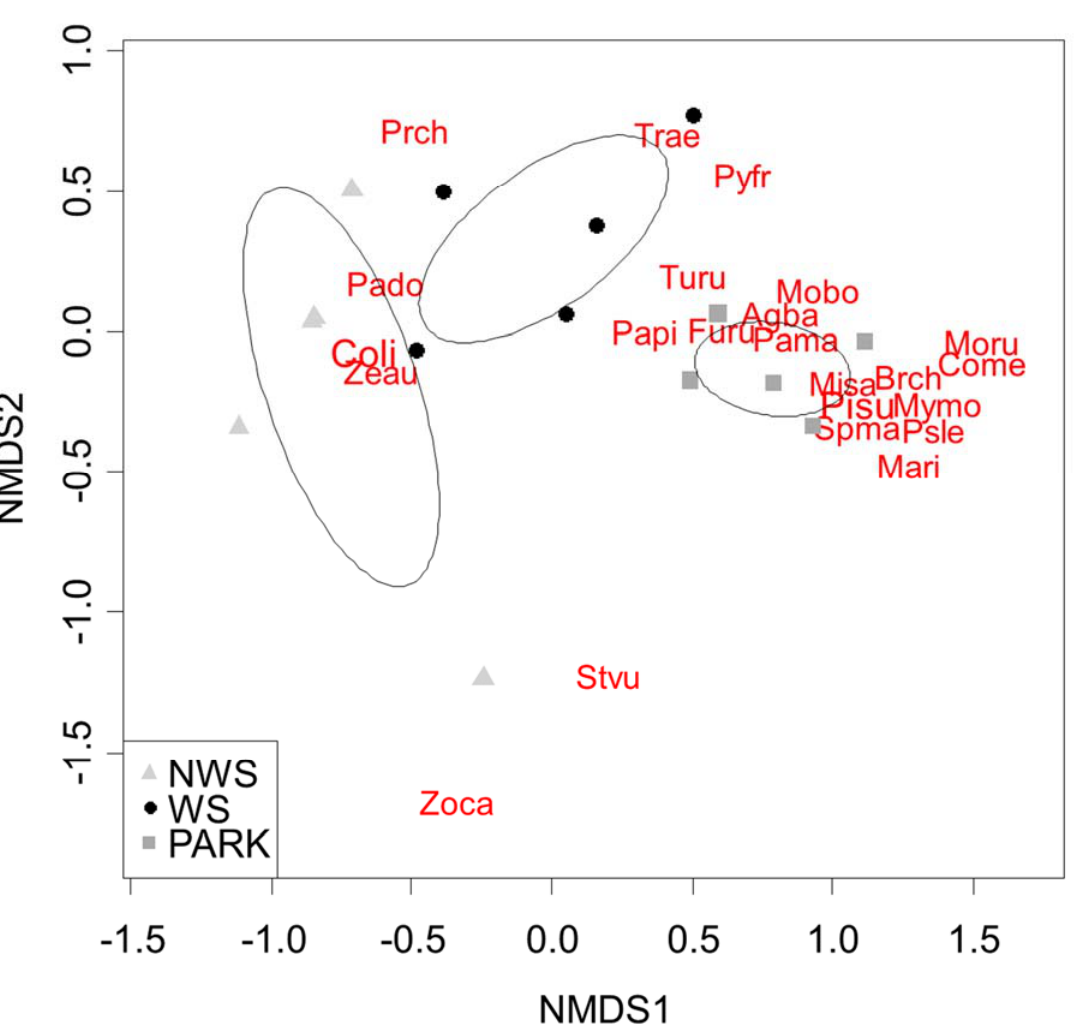
Figure 3. Non-metric multidimensional scaling (NMDS) ordination based on species abundances within different habitat types (NWS = non-wooded streets; WS = wooded streets; and parks) in Buenos Aires city (stress = 0.095). Agba = Agelaioides badius ; Brch = Brotogeris chiriri Coli = Columba livia ; Come = Colaptes melanochloros ; Furu = Furnarius rufus ; Mari = Machitornis rixosa ; Misa = Mimus saturninus ; Mobo = Molothrus bonaeriensis ; Moru = Molothrus rufoaxilaris ; Mymo = Myiopsitta monachus ; Pado = Passer domesticus , Pama = Patagioenas maculosa ; Papi = Patagioenas picazuro ; Pisu = Pitangus sulphuratus ; Prch = Progne chalybea ; Psle = Psittacara leucophthalma ; Pyfr = Pyrrhura frontalis , Spma = Spinus magellanica ; Stvu = Sturnus vulgaris ; Trae = Troglodytes aedon ; Turu = Turdus rufiventris ; Zeau = Zenaida auriculata ; Zoca = Zonotrichia capensis